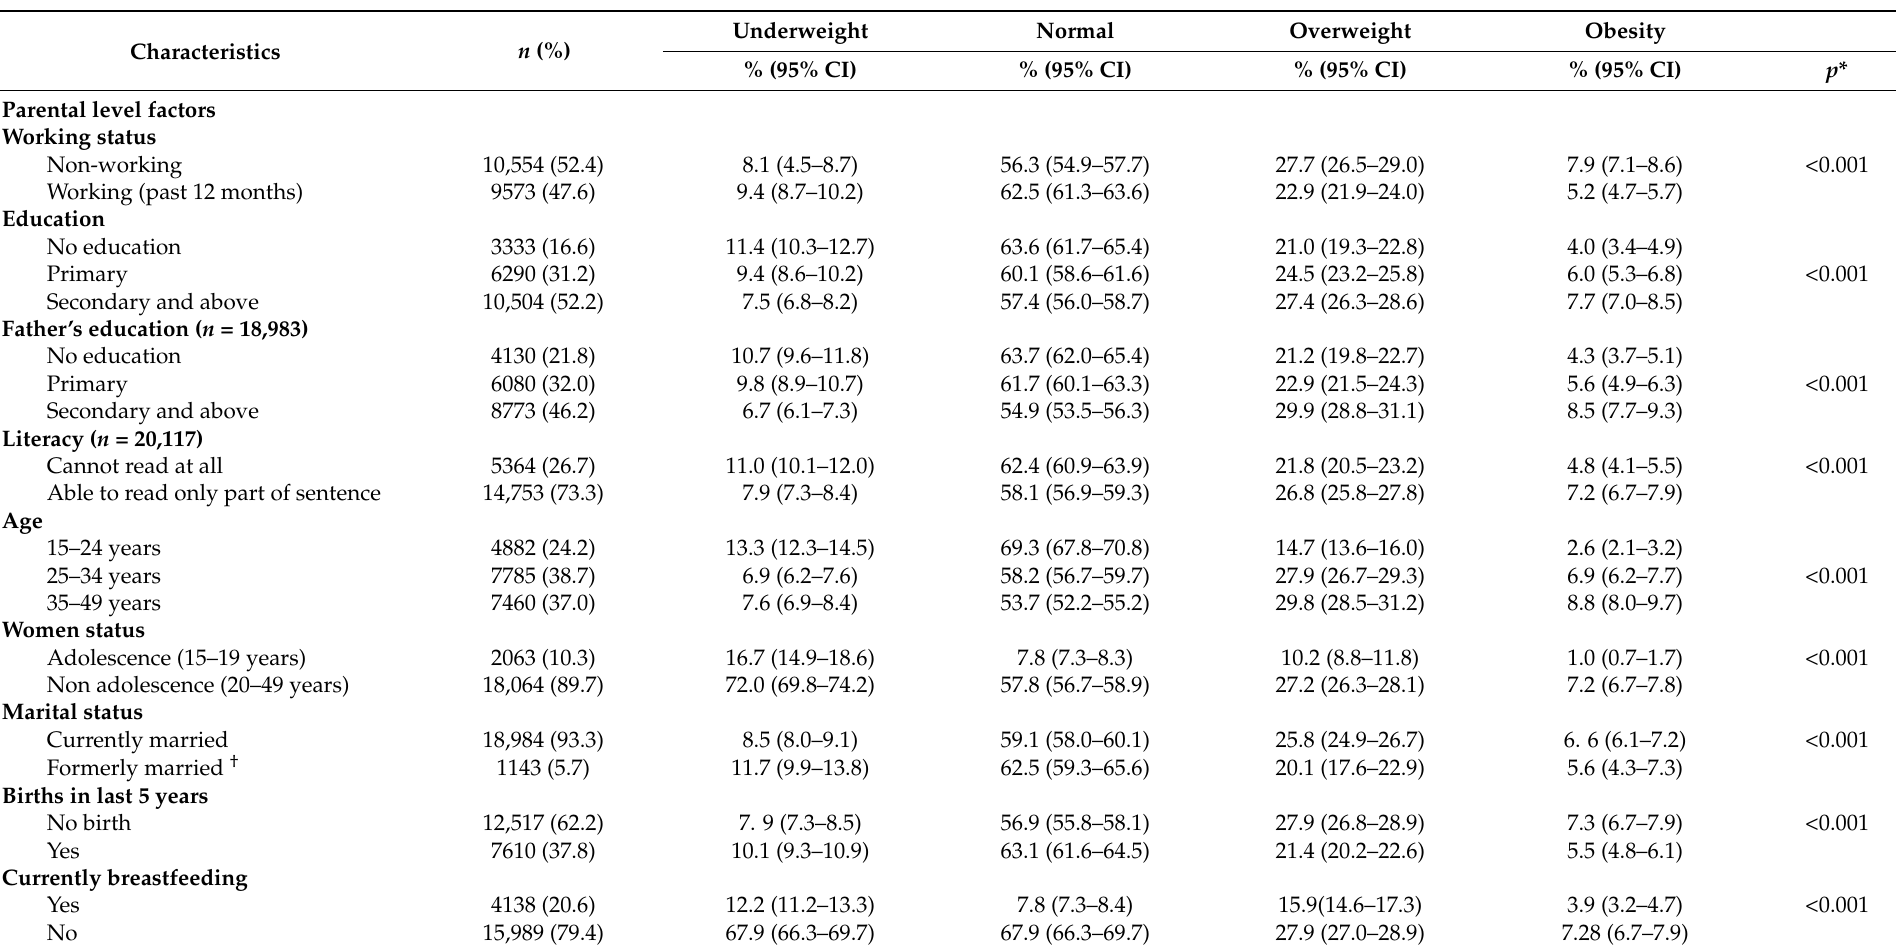
Table 1. Distribution and prevalence of underweight, normal, overweight, and obesity by individual-, household- and community-level characteristics in Bangladesh between 2017–2018 ( n = 20,127, except where